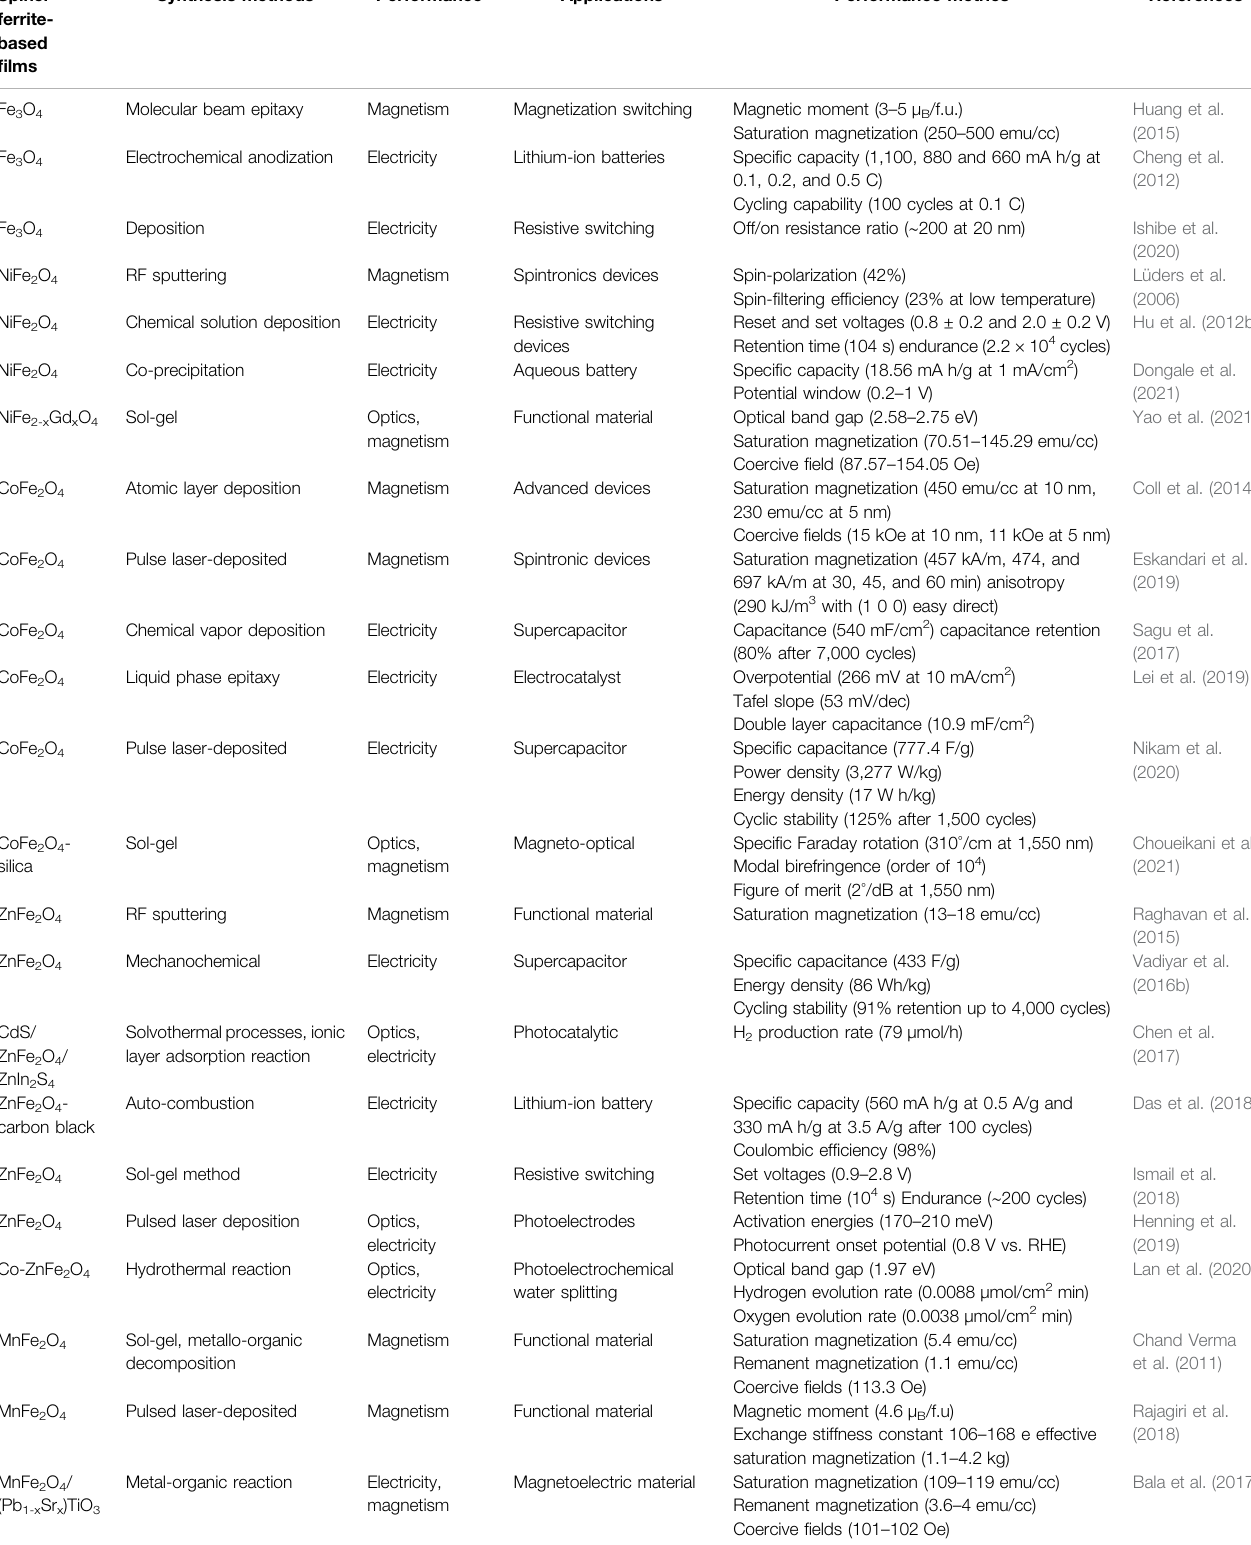
TABLE 1 | Comparison ofthe synthesis methods, performance (magnetism, electricity, and optics), typical application examples, and performance metrics for typical spinel ferrite-based thin fi lms. Spinel